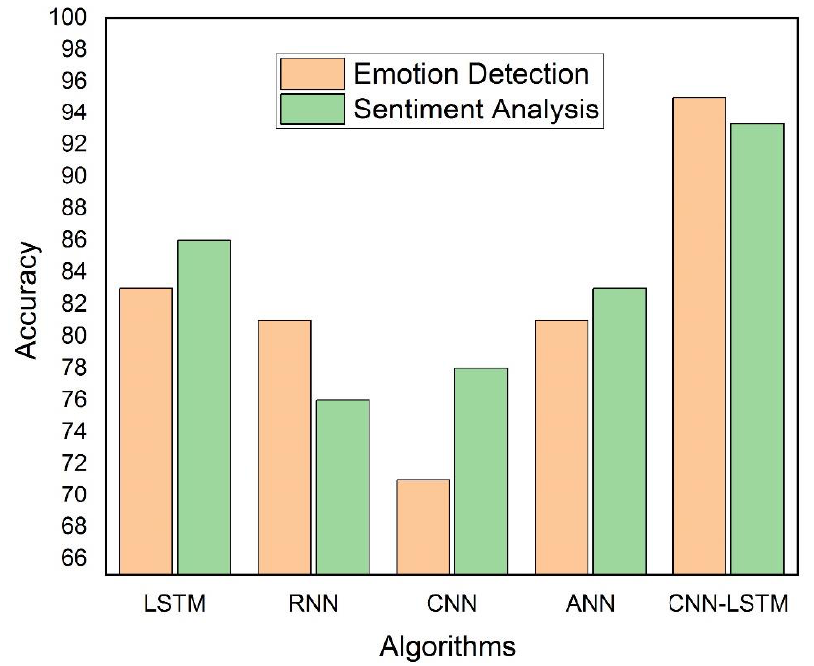
Figure 7. Proposed Method Results Compare some Machine Learning Fundamental Algorithms.